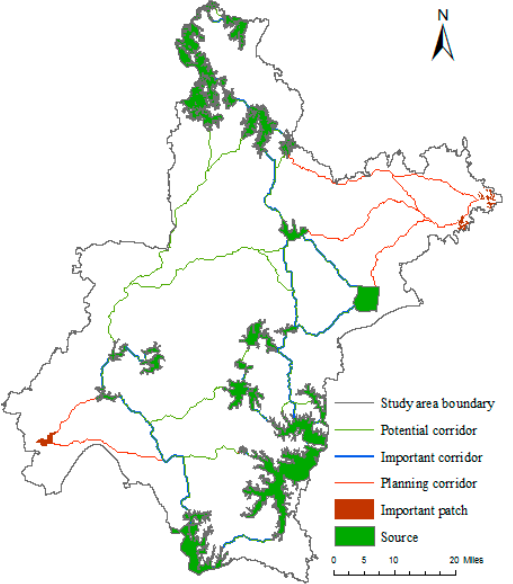
Figure 9. Planning corridor map of the study area.